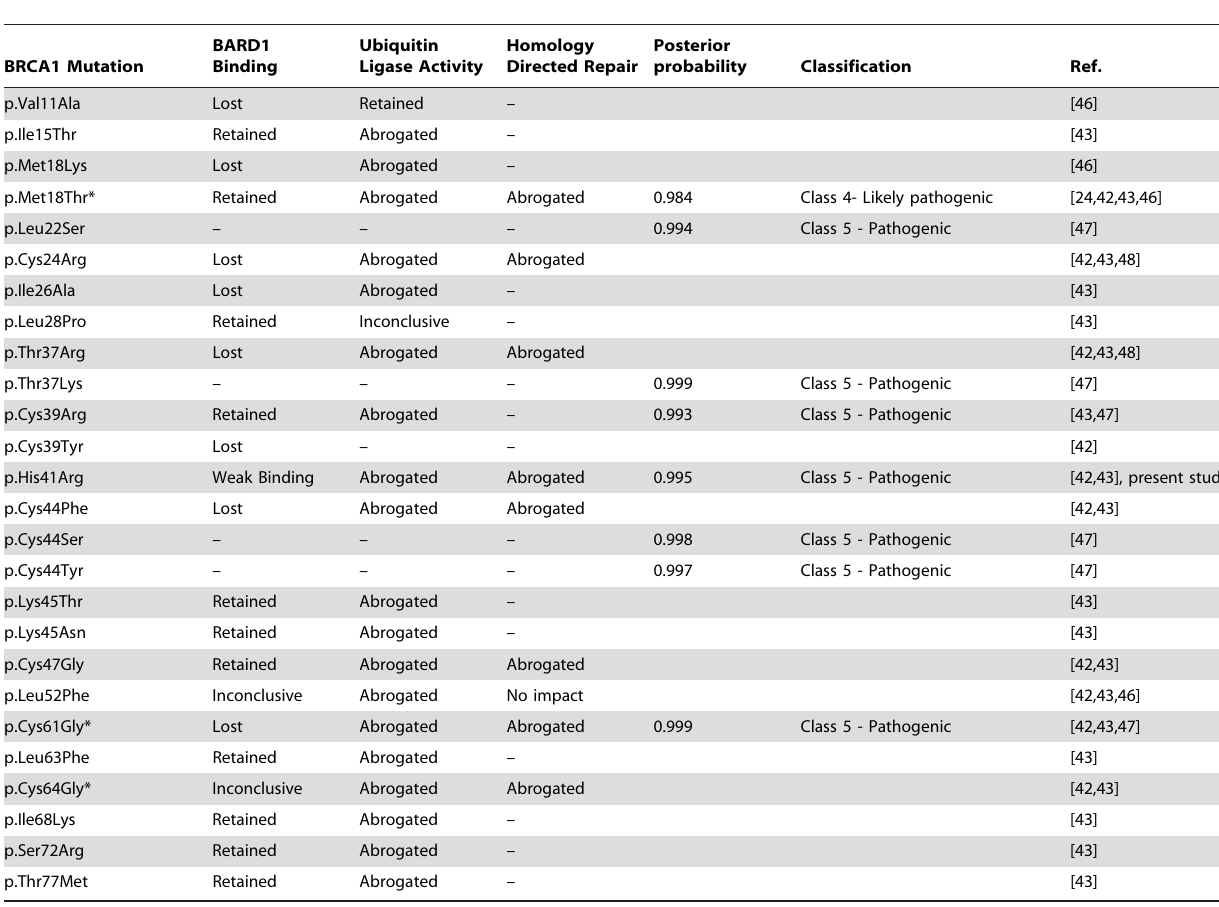
Table 3. BRCA1 RING-domain variants with reported loss of function on the basis of in-vitro functional assays and/or (likely) clinically significant from multifactorial likelihood